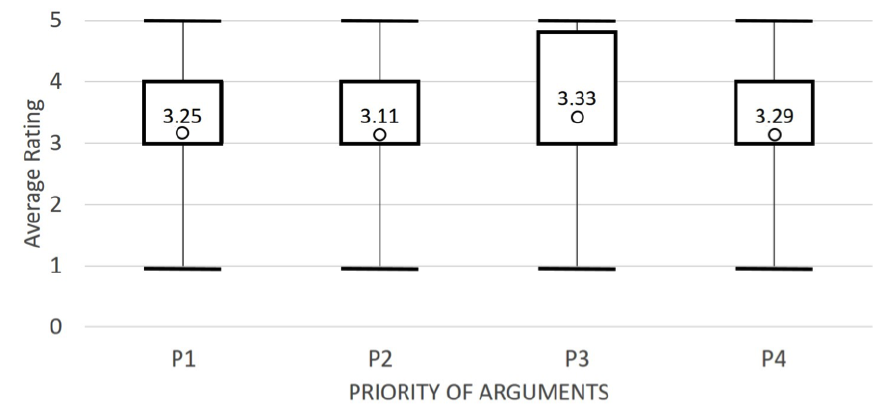
Figure 5. Average ratings provided by the students for each priority ordering to show the